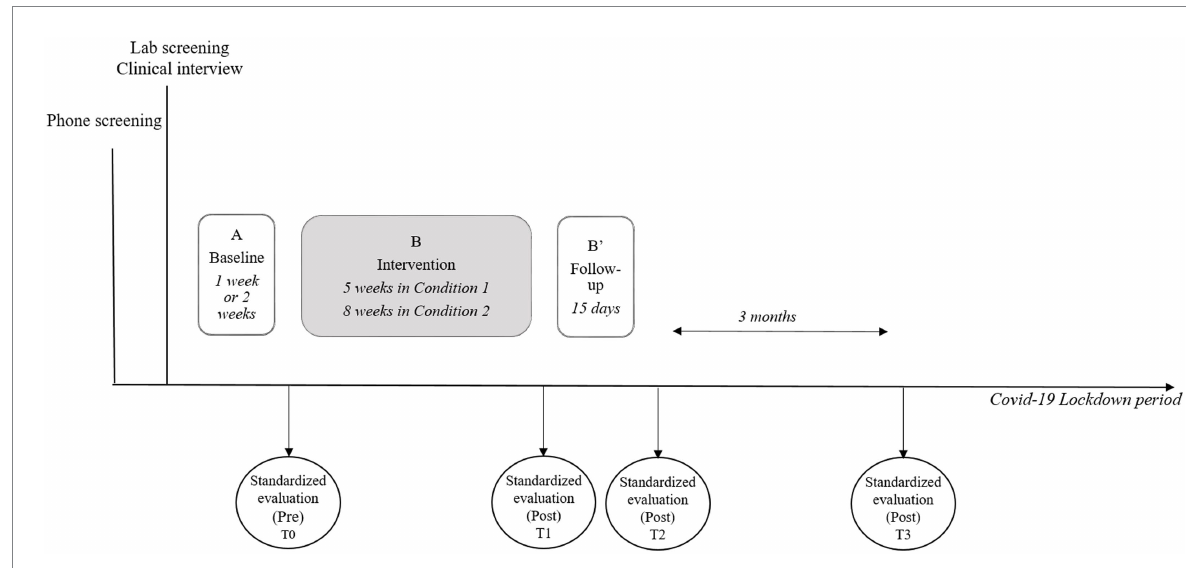
FIGURE 2 General